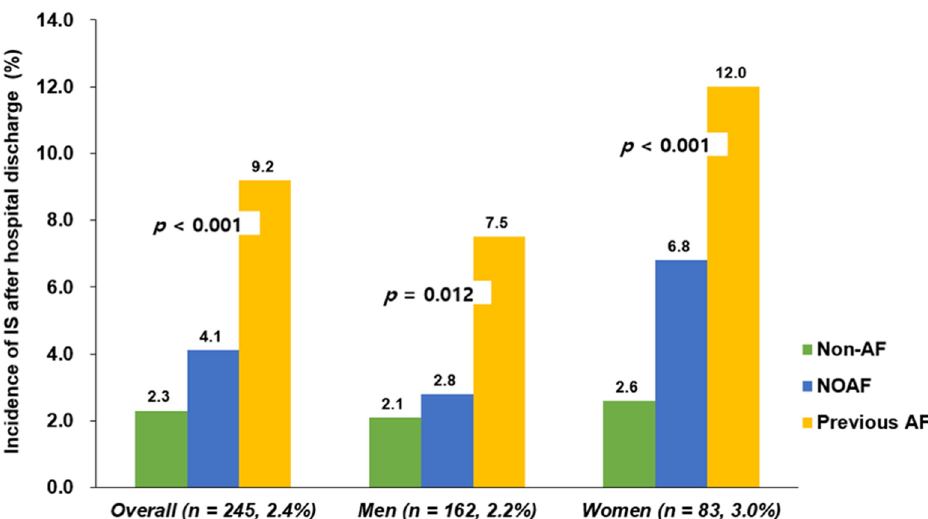
Figure 2. Incidence of ischemic stroke (IS) during follow-up after acute myocardial infarction according to onset time of atrial fibrillation (AF) among the overall population, men, and women.